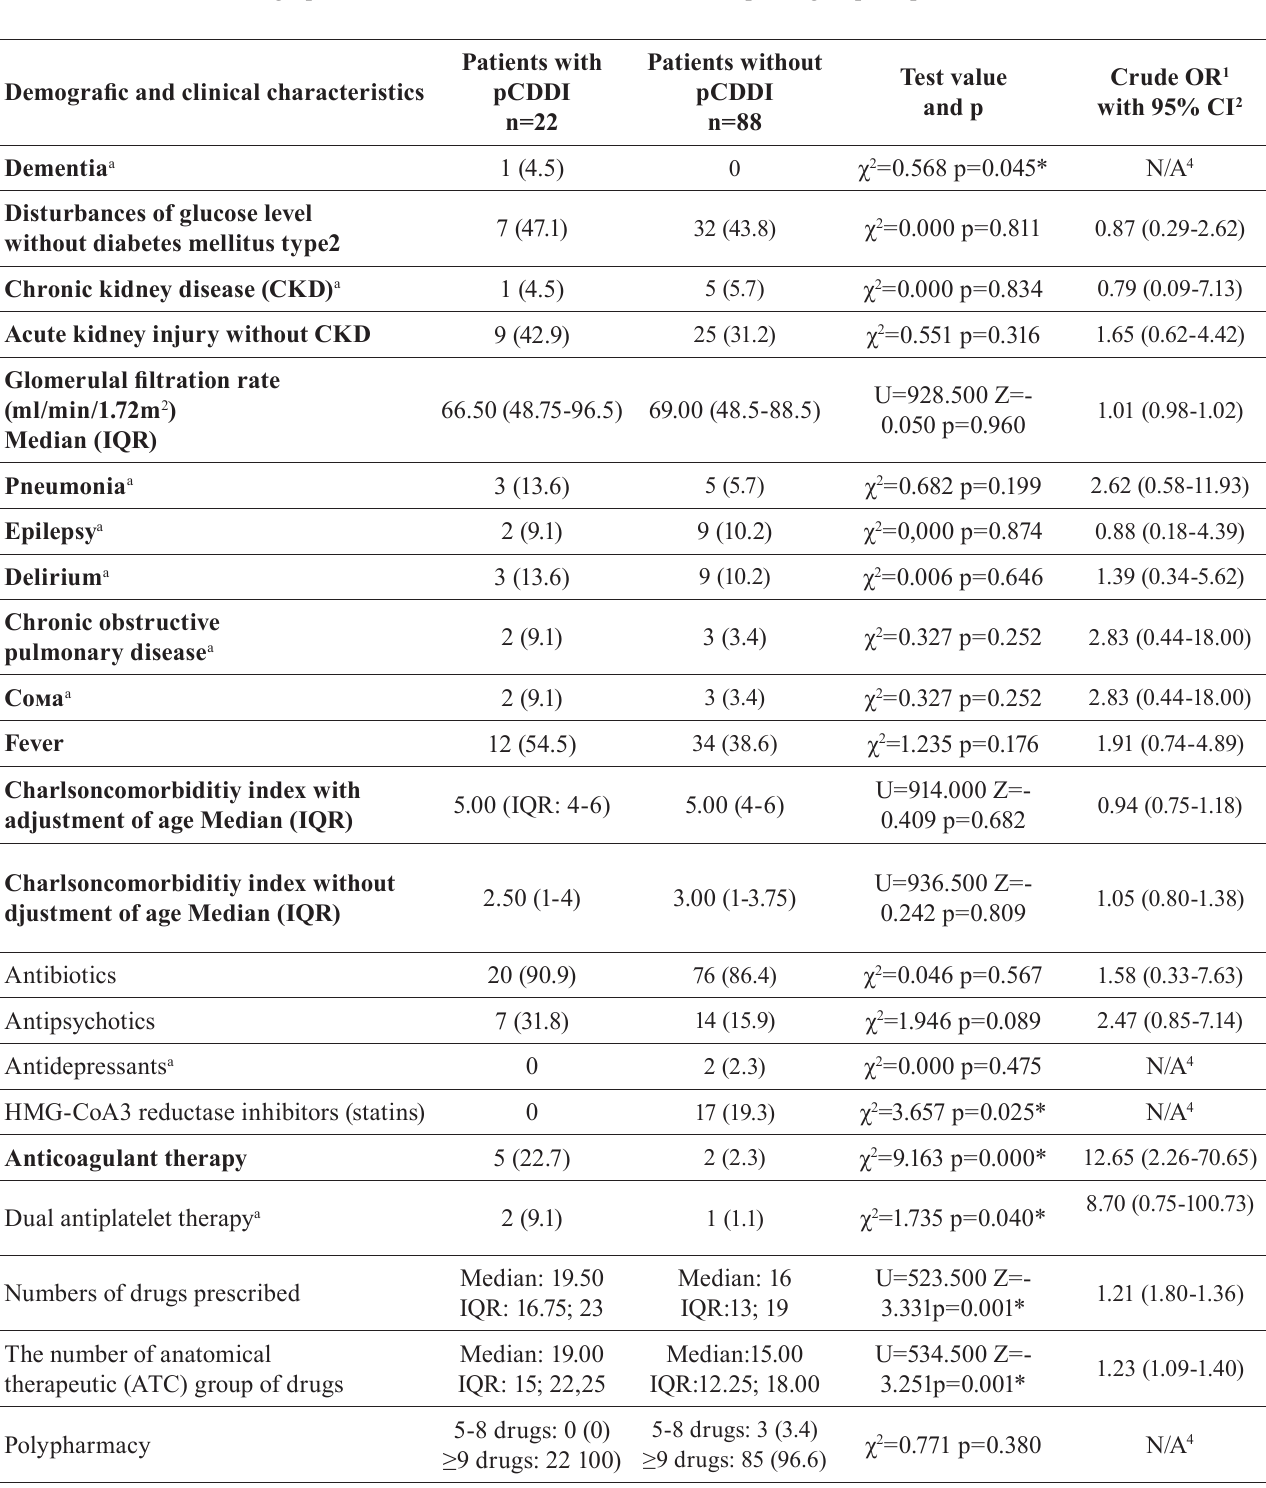
Patients with Patients without Test value Crude OR 1 pCDDI pCDDI and p with 95% CI 2 n=22 n=88 7